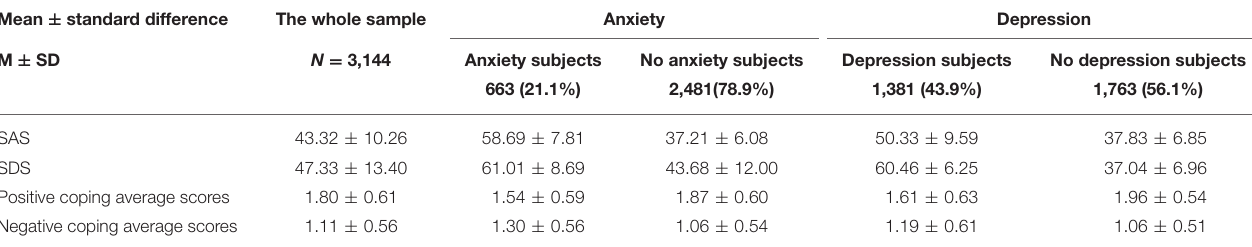
TABLE 2 | Comparison of scores between the anxiety and depression subgroups, health subgroups, and whole sample. Mean ± standard